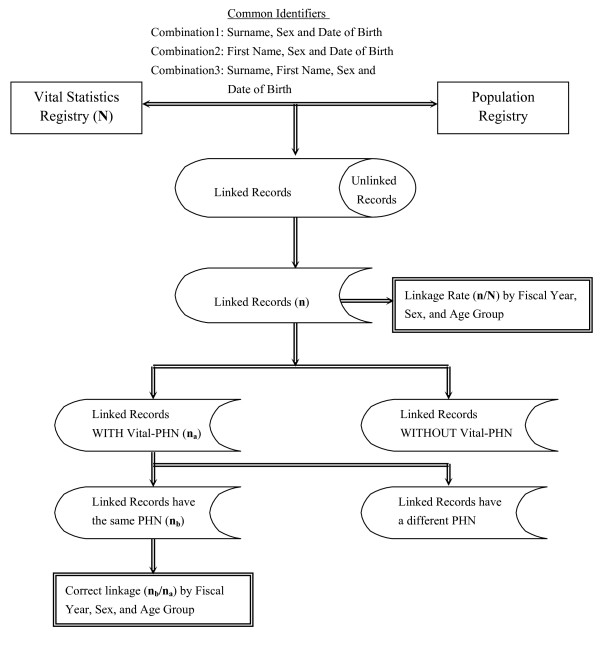
Matching Process between Vital Statistics registry and Population registry.